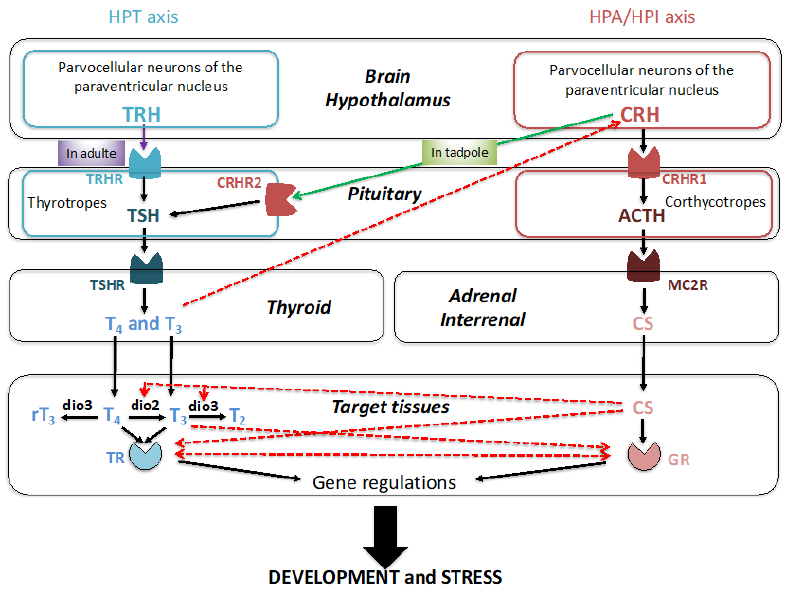
Figure 1. Hypothalamus–pituitary–thyroid and hypothalamus–pituitary–interrenal neuroendocrine axes and their interactions. The main actors of the hypothalamic–pituitary–thyroid (HPT) axis are in blue. Abbreviations: dio, deiodinase; T 4 , thyroxine; T 3 , tri-iodothyronine; rT 3 , reverse triiodothyronine; T 2 , diiodothyronine; TR, thyroid hormone receptor; TRH, thyrotropin releasing hormone; TRHR, thyrotropin releasing hormone receptor; TSH, thyrotropin; TSHR, thyrotropin receptor. The action of TRH on TSH in amphibians is observed only in juvenile and adult frogs (purple arrow). In tadpoles, TSH is controlled by CRH (green arrow). The main actors of the corticotropic (hypothalamic–pituitary–adrenal/interrenal, HPA/HPI) axis are in Bordeaux. Abbreviations: ACTH, adrenocorticotropin; CRH, corticotropin-releasing hormone; CRHR1, corticotropin-releasing hormone receptor 1; CRHR2, corticotropin-releasing hormone receptor 2; GR, glucocorticoid receptor; MC2R, melanocortin receptor 2.